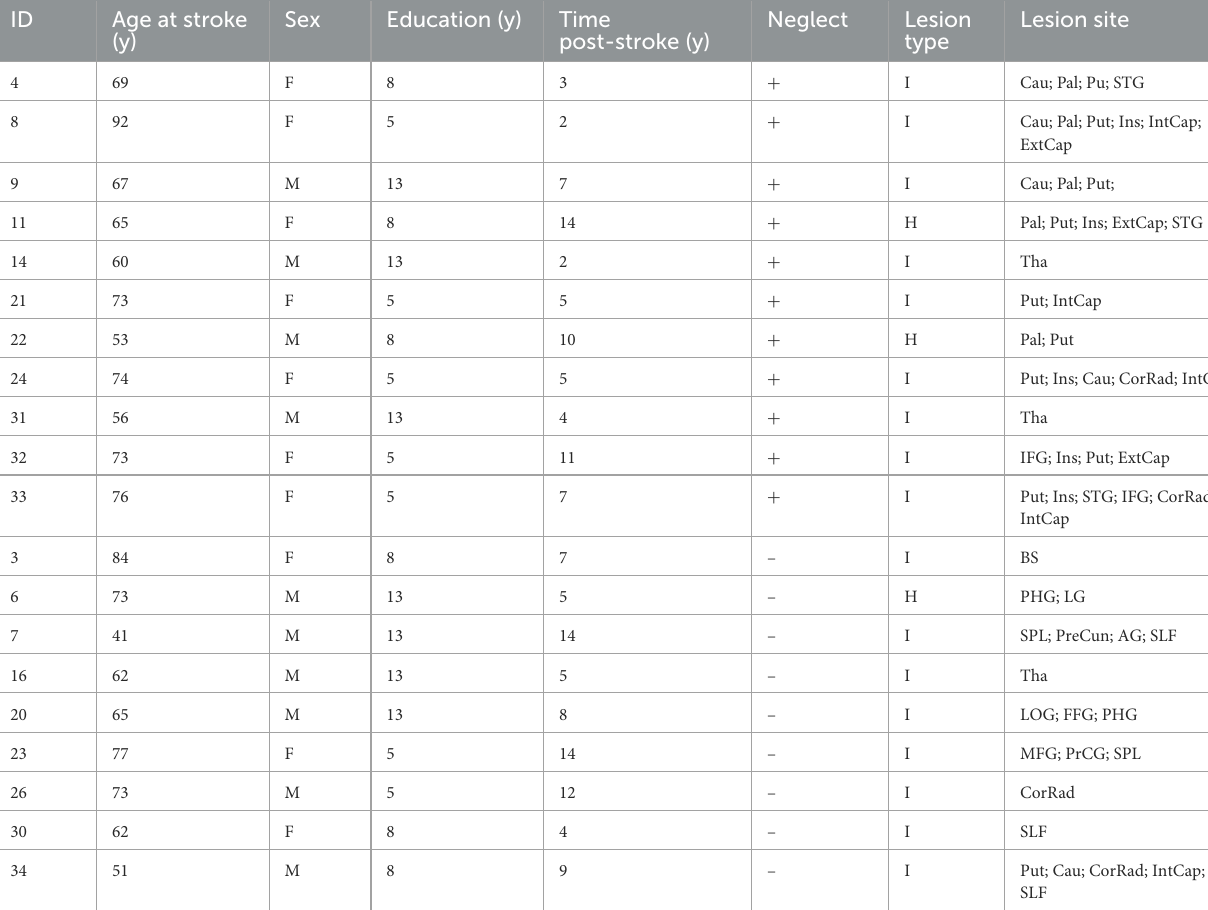
TABLE 1 Demographic and clinical characteristics of the stroke